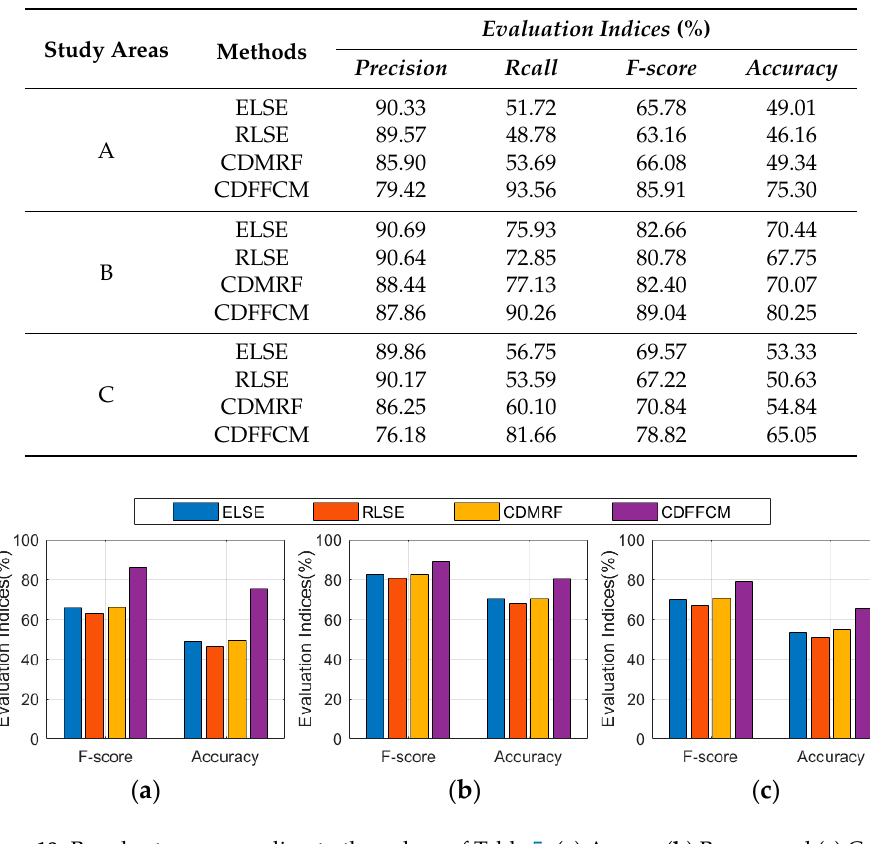
Figure 18. Bar-chart corresponding to the values of Table 5: ( a ) A-area, ( b ) B-area, and ( c ) C-area. For A-area, B-area, and C-area, ELSE, RLSE, and CDMRF provide higher Precision but